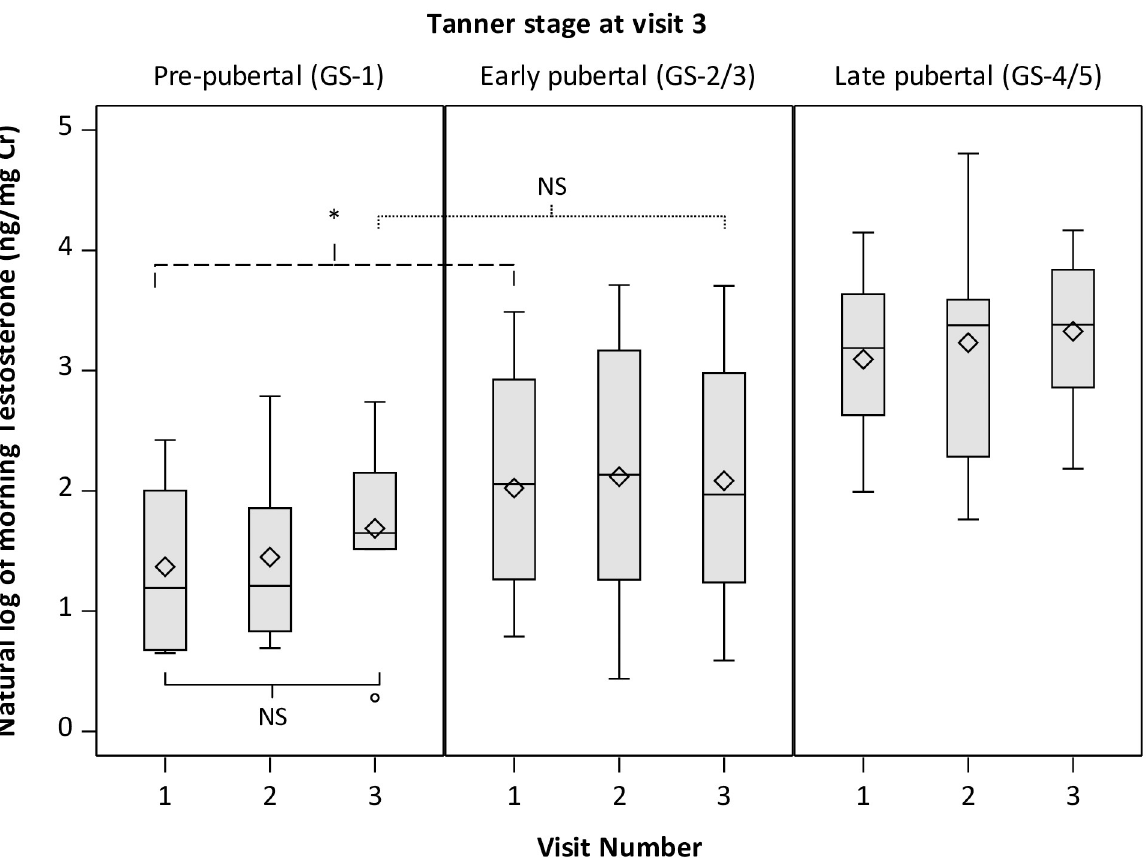
Fig 2. Morning urinary testosterone levels in boys by Tanner genital stage and visit. Boys are classified as pre-pubertal (GS-1), early pubertal (GS-2/3) or late pubertal (GS-4/5) based on self-report of Tanner genital stage at visit 3. P values from repeated measures analysis adjusted for BMI Z-score shown for V3 vs. V1 levels among GS-1 boys (solid), GS-2/3 vs. GS-1 at V1 (dashed) and GS-2/3 vs. GS-1 at V3 (dotted). NS = p � 0.05; � p < 0.05; �� p < 0.01.